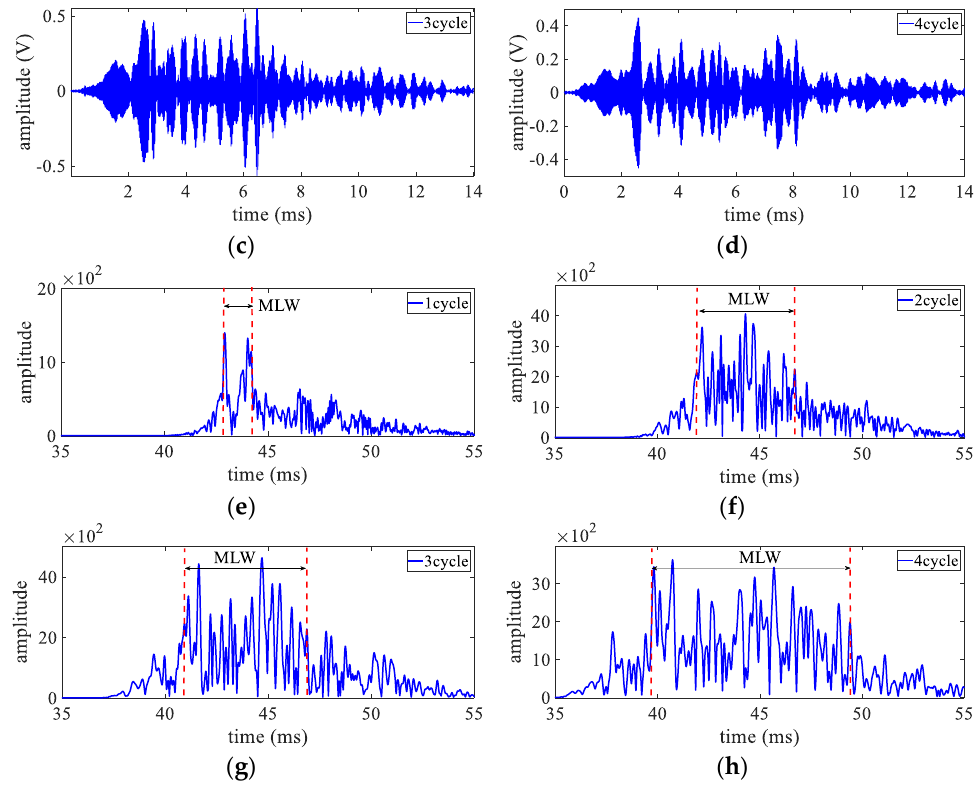
Figure 8. Results analysis of encoding excitation by 63 − bit Kasami sequence under different carrier cycles, ( a – d ) the corresponding received signals, ( e – h ) the corresponding decoding results.